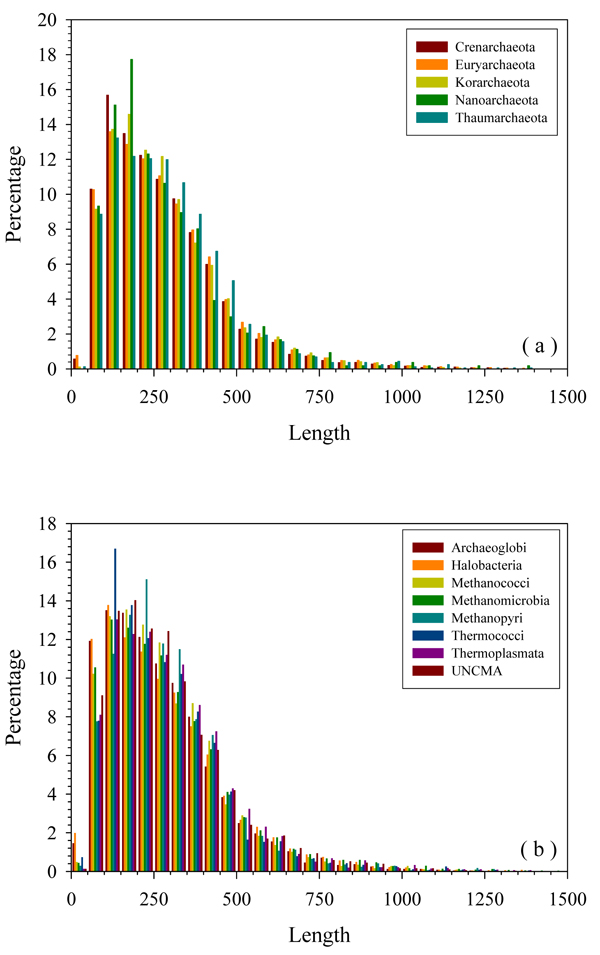
Length distribution of proteins in five phyla (a) and eight classes (b) of Euryarchaeota. X-axis: “X” length of protein; Y-axis: percentage of proteins with “X” length. The upper limit of the x-axis is taken as 1500 residues for visualization purposes. However, there are still scattered distributions of proteins beyond this uplimit.